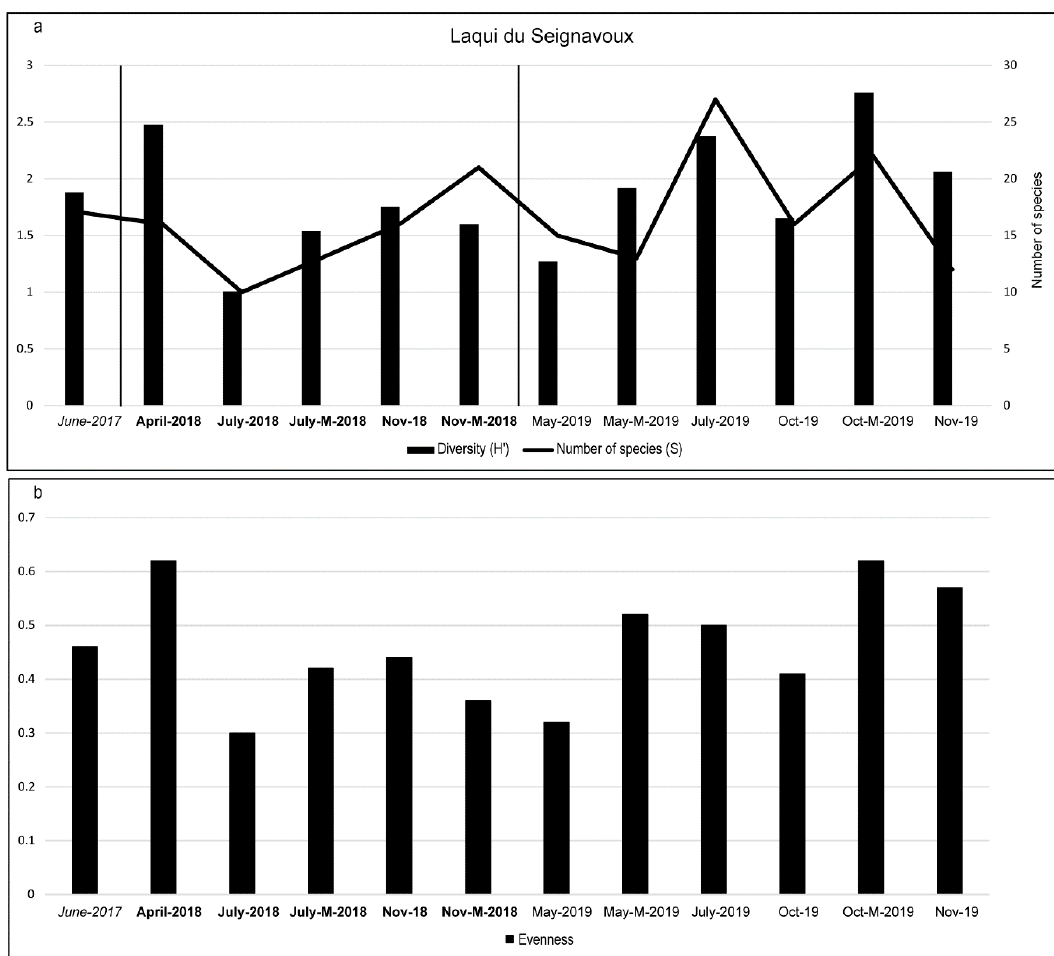
Figure 6. ( a ) Shannon–Weaver diversity and number of species (richness) for each sampling period (M = macrophytes); ( b ) species evenness for each sampling period (M =